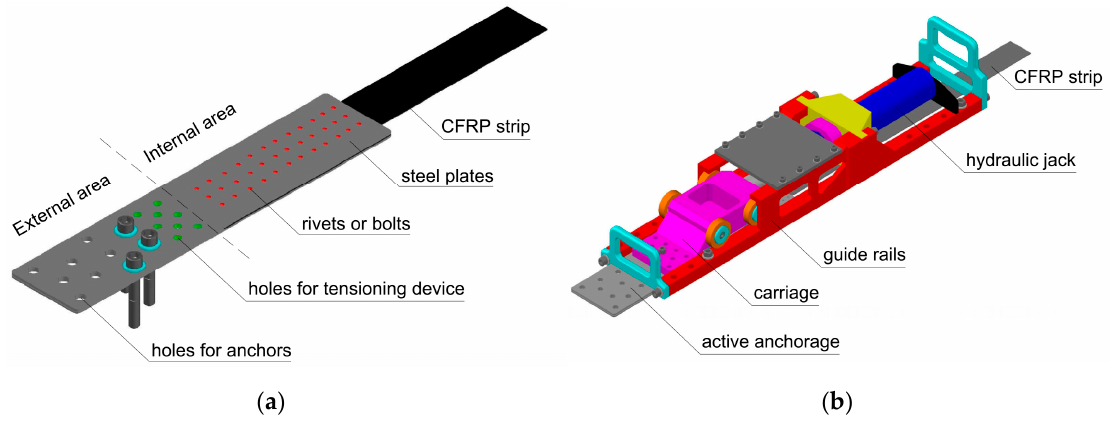
Figure 1. ( a ) Scheme of the active anchorage. ( b ) Scheme of the tensioning device.